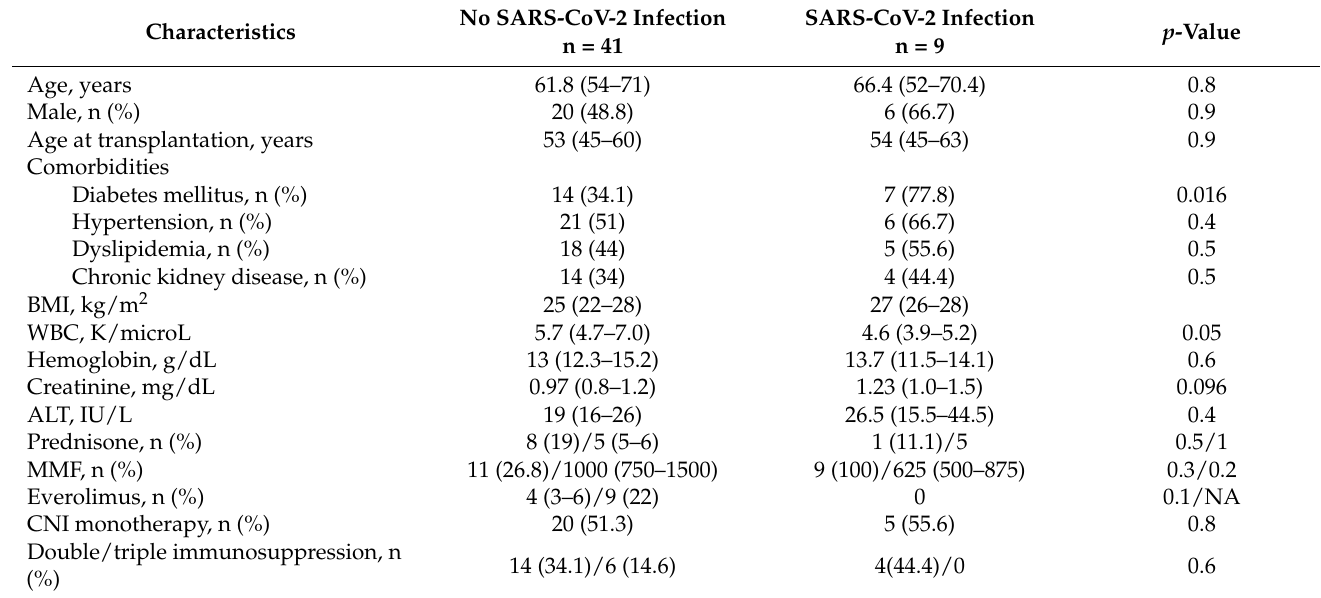
Table 5. Comparison of baseline characteristics of 50 patients who received a fourth BNT162b2 mRNA dose vaccine with and without breakthrough